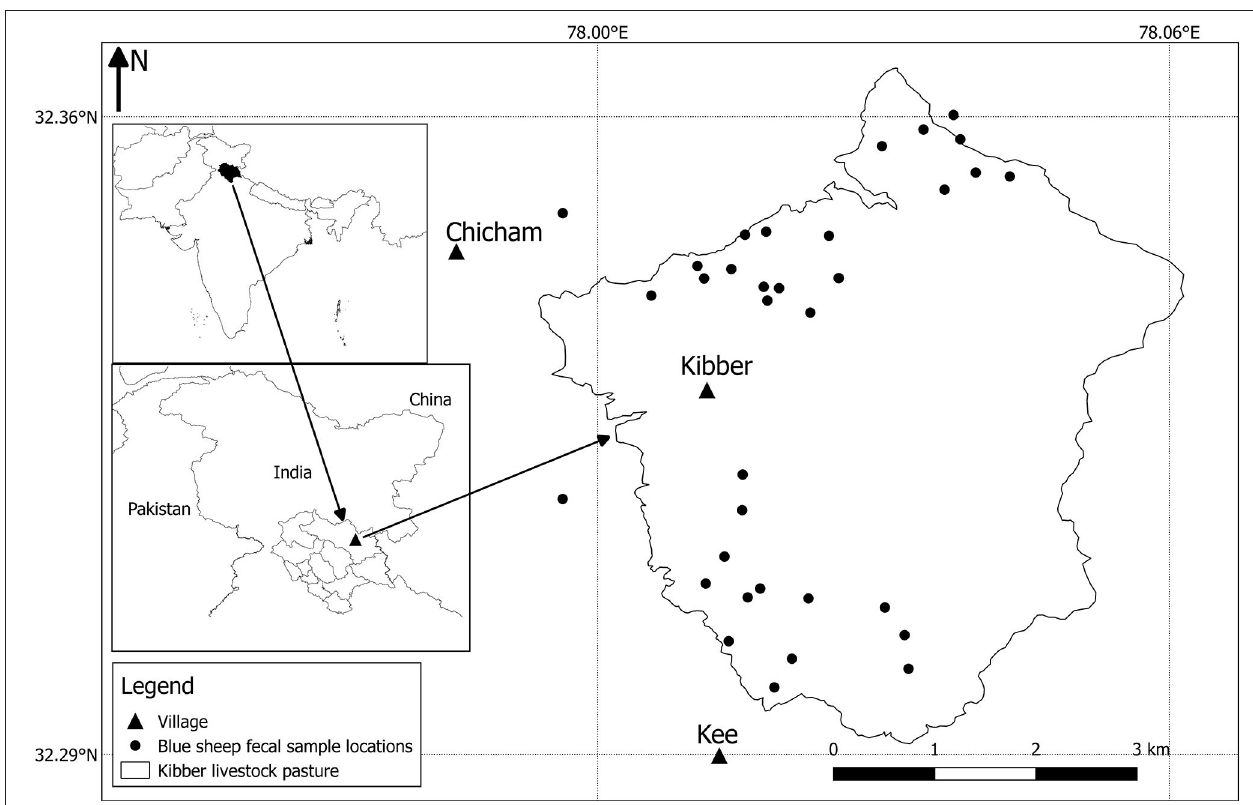
FIGURE 3 | Map displaying bharal (blue sheep) faecal sample locations within the Kibber livestock pasture. The inset maps show the location of the study area within the Lahaul-Spiti district of Himachal Pradesh state,